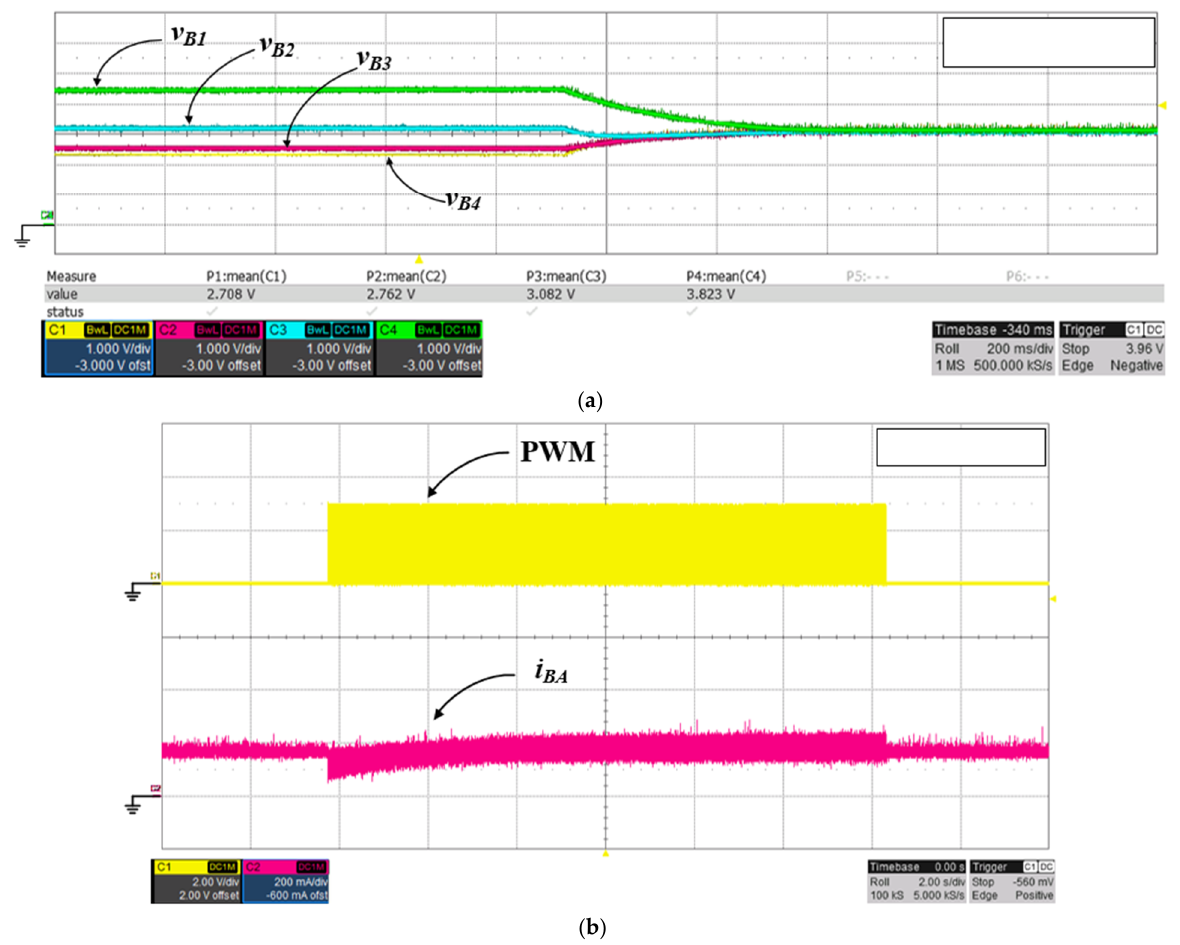
Figure 16. Experiment results: ( a ) cell voltage ( b ) cell current. Figure 16b shows the cell current waveform during the voltage balancing control